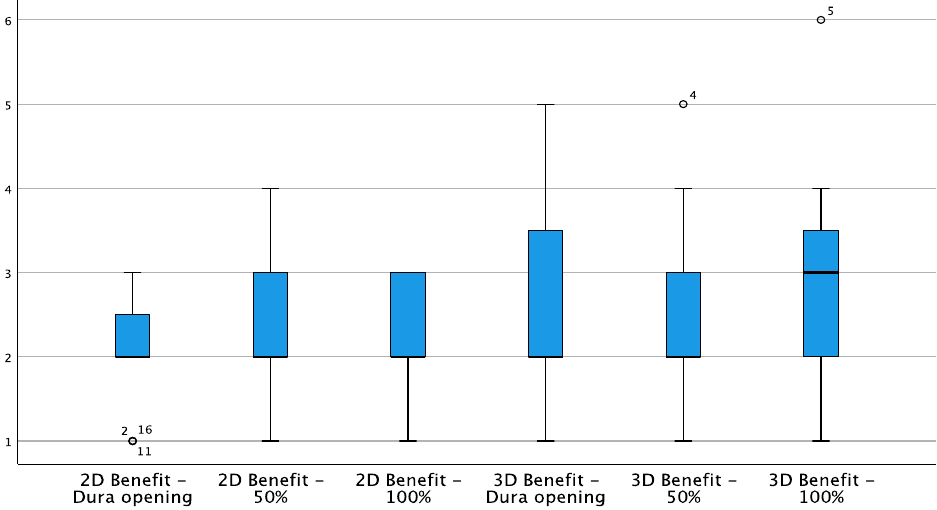
Figure 4. Box plot showing 2D and 3D benefit variations during different stages of resection. White circles = low potential outlier (more than 1.5 inter-quartile range at most 3 inter-quartile